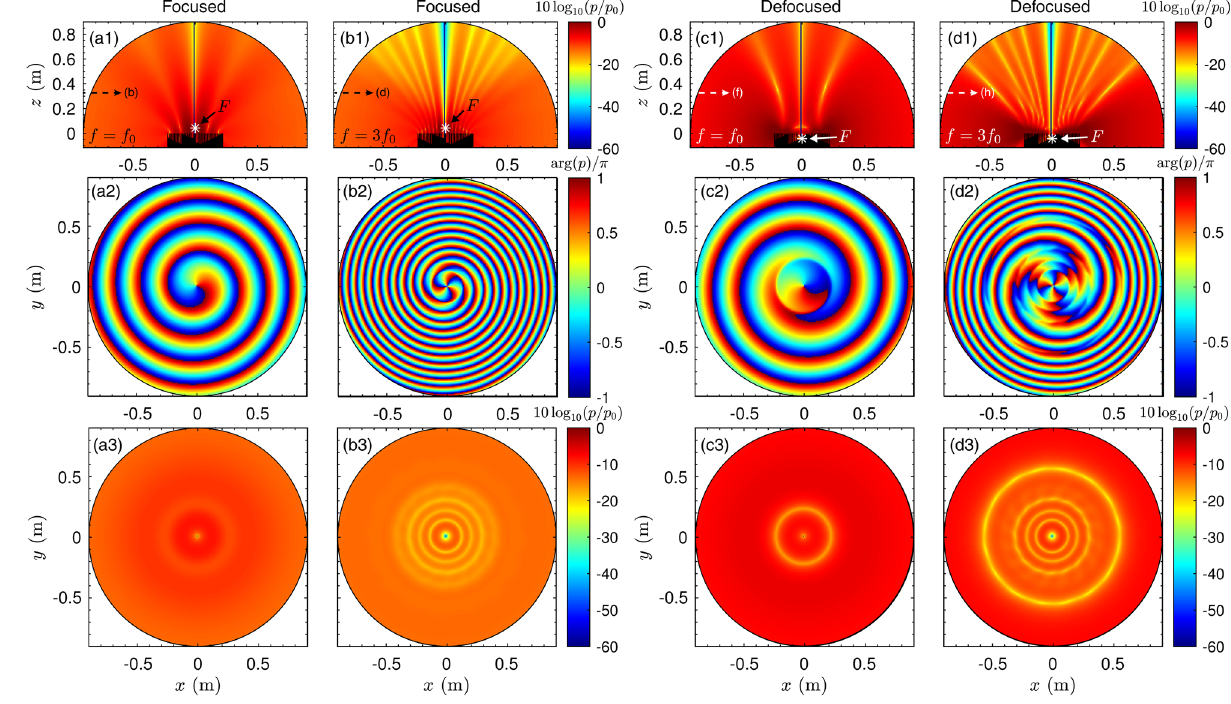
f 0 . Figure 3. ( a1 ) Scattered field for the focusing metasurface in the near field at the design frequency f = 2 a . ( b1 ) Scattered field for the ( a2 ) Phase and ( a3 ) magnitude of the scattered field in the transversal plane z = 3 f 0 . ( b2 ) Phase and (b3) magnitude of the scattered field focusing metasurface in the near field at frequency f = 2 a . ( c1 ) Scattered field for the defocusing metasurface in the near field at the design in the transversal plane z = 2 a . ( d1 ) Scattered f 0 . ( c2 ) Corresponding phase and ( c3 ) magnitude in the transversal plane z frequency f = = 3 f 0 . ( d2 ) Corresponding phase and ( d3 ) field for the defocusing metasurface in the near field at frequency f = 2 a . magnitude in the transversal plane z =